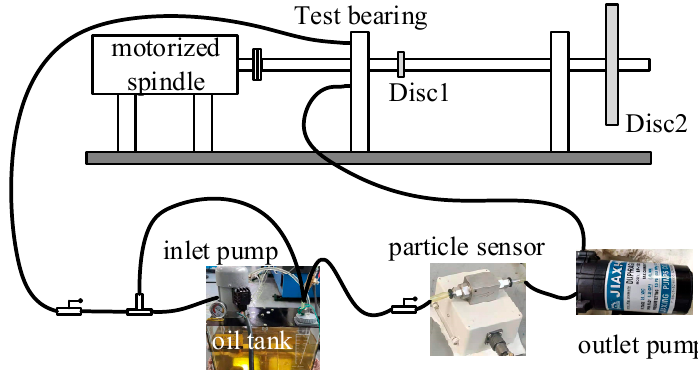
Figure 3. Forced lubrication system.